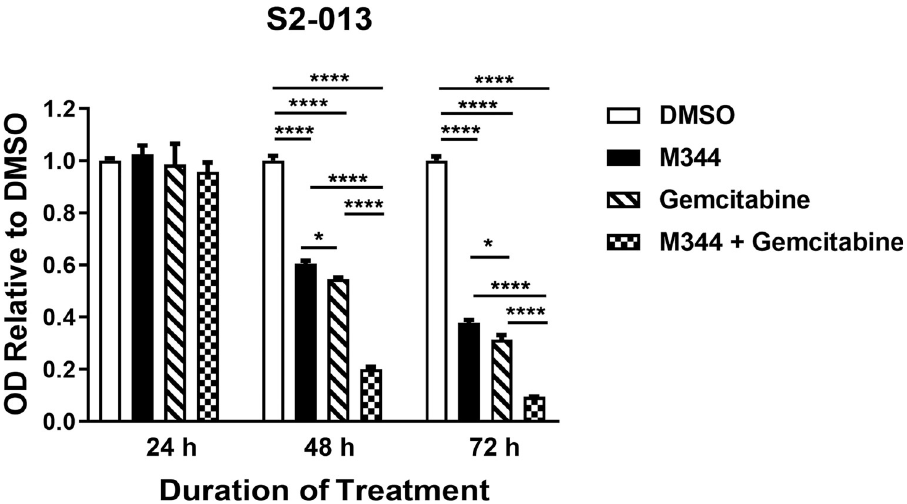
Fig 11. S2-013 pancreatic cancer cell proliferation is decreased by treatment with the combination of M344 and gemcitabine more than by either treatment alone at 48 or 72 hours post-treatment. The proliferation of S2-013 cells following treatment with DMSO, 10 μ M M344, 100 nM gemcitabine, or 10 μ M M344 + 100 nM gemcitabine was monitored by MTT assay at the indicated time points. These results are representative of the data from 4 separate experiments. The error bars represent the standard error of the mean. The results were compared using Ordinary One- way ANOVA with Tukey’s Multiple Comparisons test in GraphPad Prism Version 8.4.2. The asterisks indicate the p values: � p < 0.05, �� p < 0.01, ��� p < 0.001, ���� p < 0.0001.